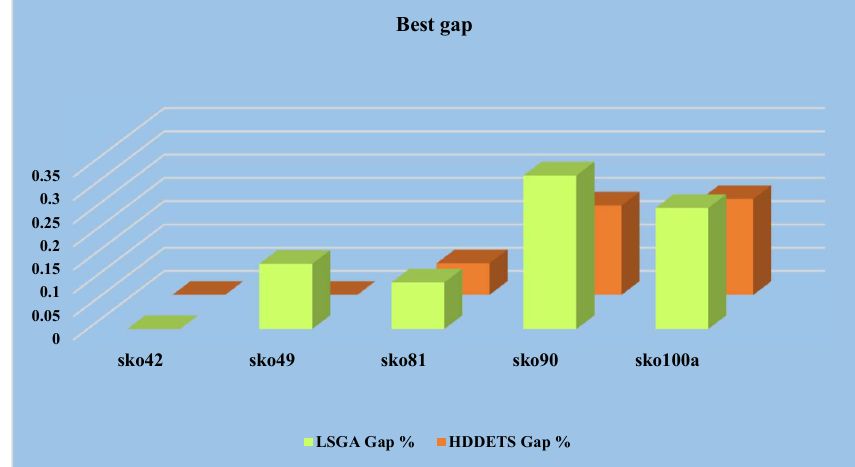
Fig. 11 . Comparative study 2 between LSGA and